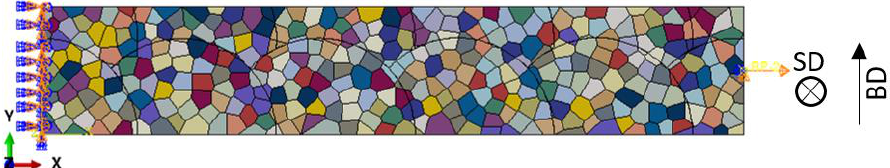
Figure 10. The finite element model indicating the displacement boundary conditions and remote applied load for 199 grains.